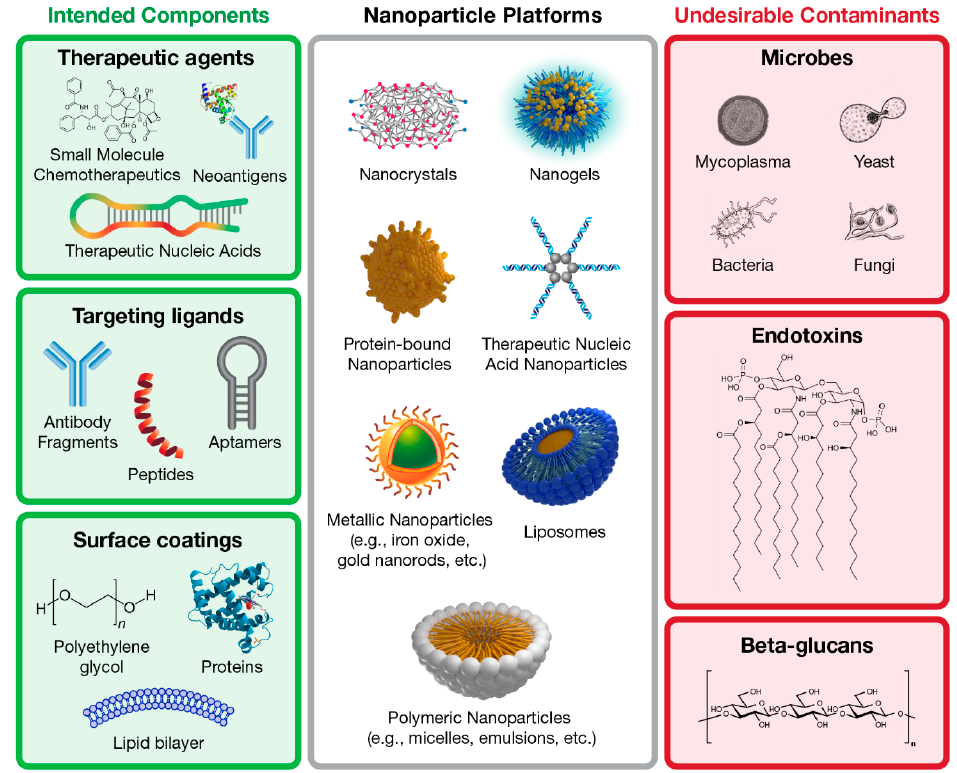
Figure 1. The complex nature of nanotechnology-based therapeutics. Nanomaterials can have a diverse chemical compositions and a broad range of physicochemical properties (e.g., size, charge, and surface functionalization), and are used for delivery of a variety of therapeutic cargoes (e.g., proteins, peptides, antibodies, and aptamers). The diverse nature of these materials, coupled with complex manufacturing procedures, makes nanomaterials prone to contamination with microbial components (e.g., endotoxin, beta-glucans, and flagellin) that act as innate immunity modulating impurities, thereby confounding the results of both e ffi cacy and safety